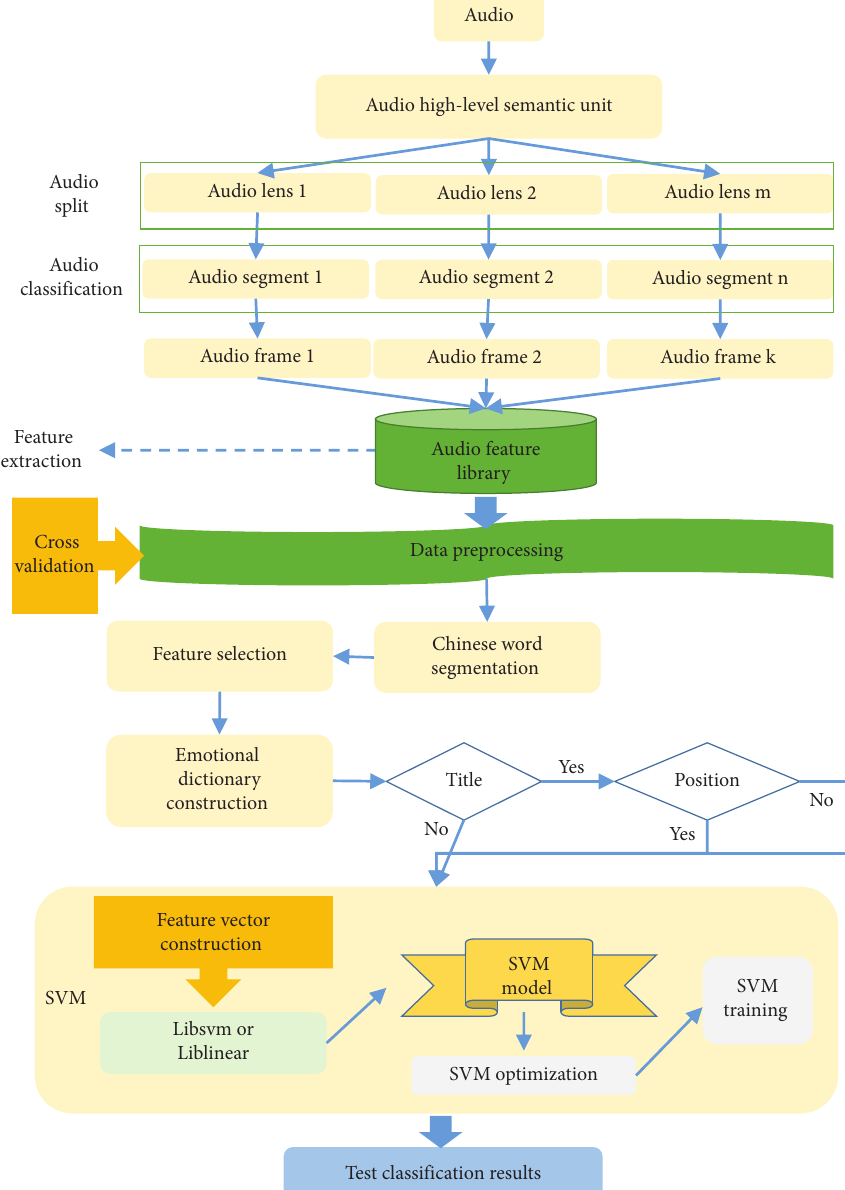
Figure 2: Lyrics sentiment analysis process.